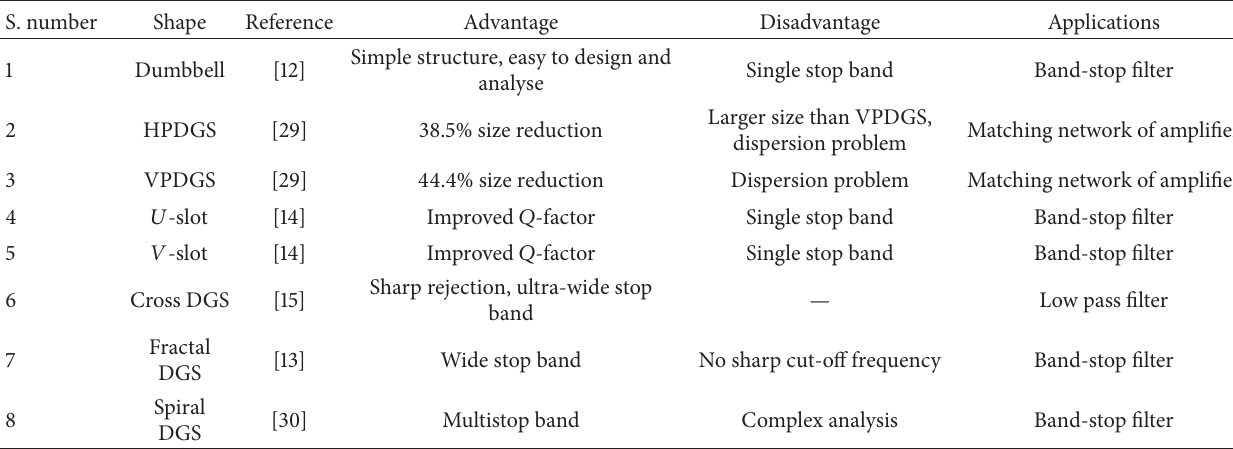
Table 2: Applications, advantages, and disadvantages of different type of